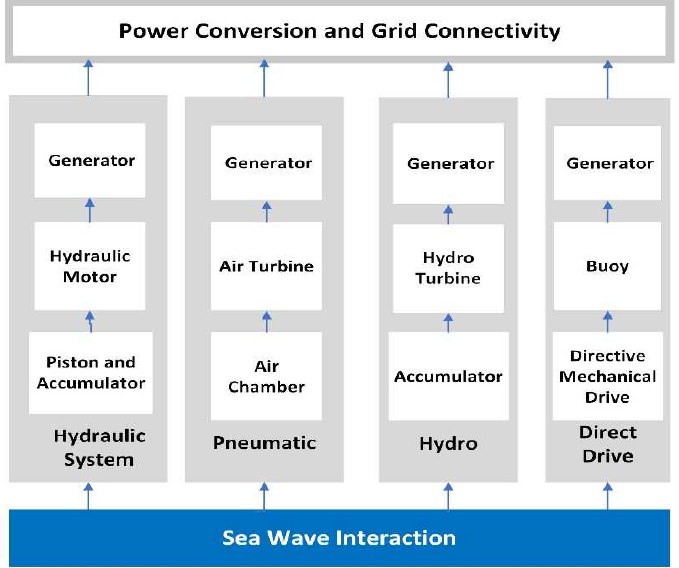
Figure 2. Typical PTO systems used in the wave energy